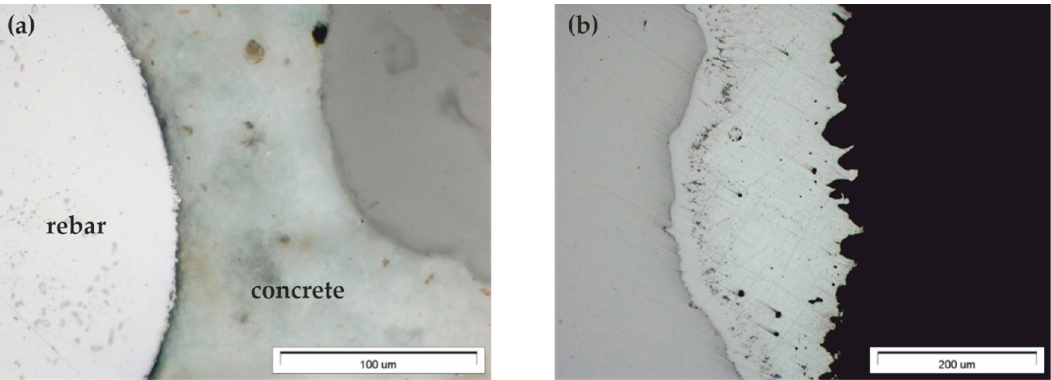
Figure 10. Microstructure of the joint between concrete and rebar made of galvanized steel B500SP (LM): ( a ) general view of a cross-section of a steel bar in concrete ( b ) morphology of the zinc coating on the rebar in concrete